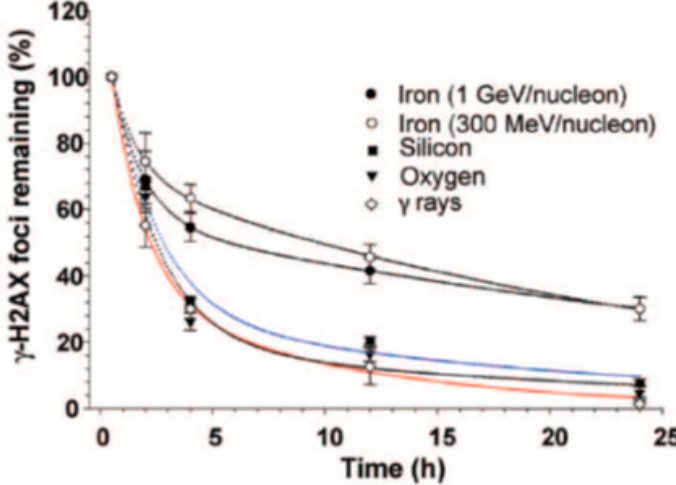
Figure 2. Quantification of γ -H2AX foci in human skin fibroblasts exposed to 1 Gy of iron, silicon, oxygen particles and γ -rays. Reproduced with permission © 2019 Radiation Research Society.